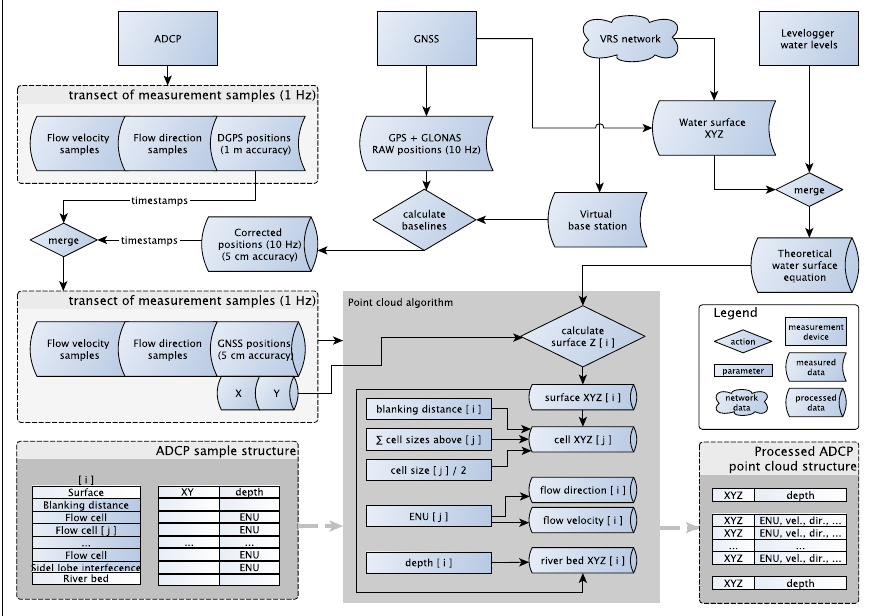
Figure 6. Conceptual process of creating a point cloud of flow data from ADCP, virtual reference station (VRS)-GNSS and water level